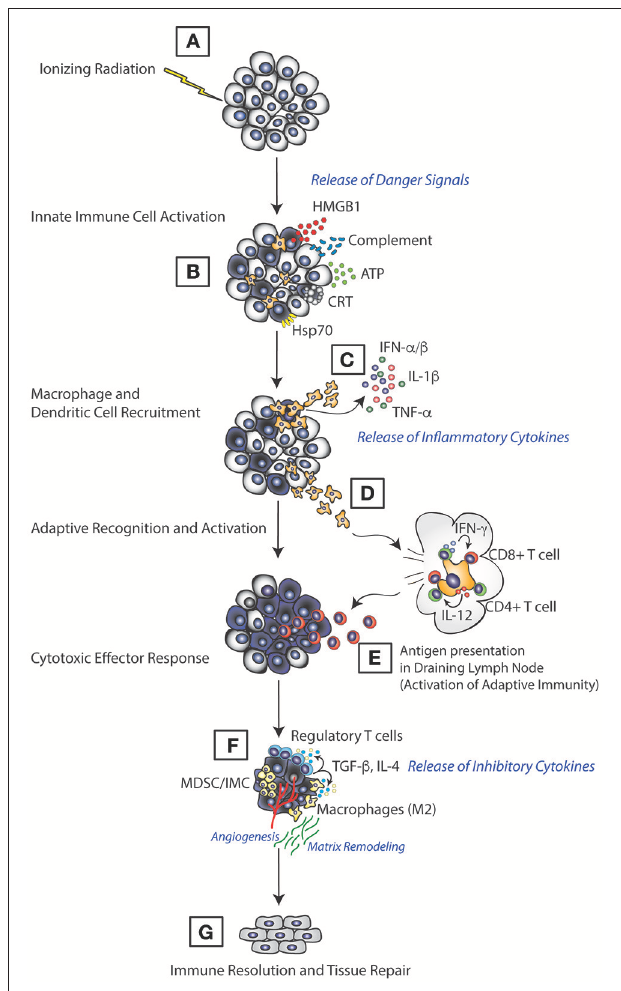
FIGURE 1 | Model of immune activation following RT. RT induces direct tumor cell death which leads to release of various immunological mediators in the form of ATP, HMGB1, calreticulin, and complement (A) . This leads to innate immune cell priming, where innate immune cells, such as dendritic cells and macrophages, recognize these mediators through various receptors, migrate to the tumor (B) and induce the production of inflammatory molecules such as TNF- α , IL-1 β , and type I IFN (C) . Innate cells then migrate to the lymphoid tissue (D) carrying antigens acquired from the tumor cell for presentation (E) resulting in activation of the adaptive immune response and elimination of tumors. Once tumors are eradicated, the RT-induced inflammation is suppressed (F) , and tissue damage associated with tumors and the immune response is repaired (G)